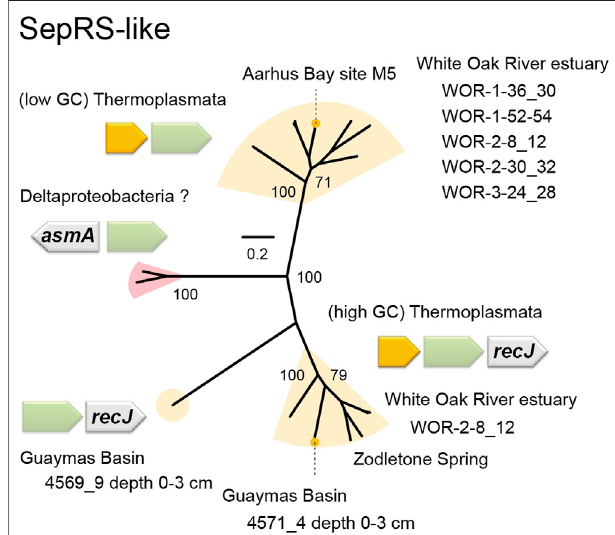
FIGURE 7 | Phylogenetic tree and operon structures of SepRS-like homologs. This unrooted tree was made by maximum likelihood estimation with 100 replicates. The bootstrap values (percentages) are given. The metagenomic origins are shown for each clade. The (low GC) Thermoplasmata SepRS-like genes are headed by a TRAX homolog gene (yellow), while the (high GC) Thermoplasmata SepRS-like genes are followed by a recJ gene. The novel SepRS-like group (pink) may belong to Deltaproteobacteria, because their neighboring genes show high similarities toDeltaproteobacteriagenes.The asmA genemayencodethebacterialouter membrane protein assembly protein